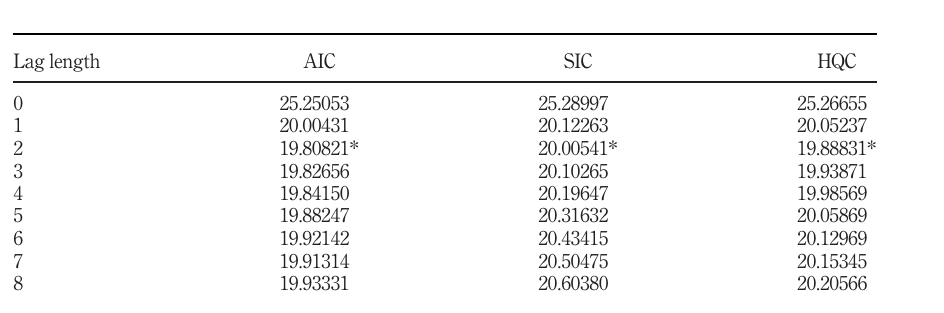
Table 4. VAR lag order